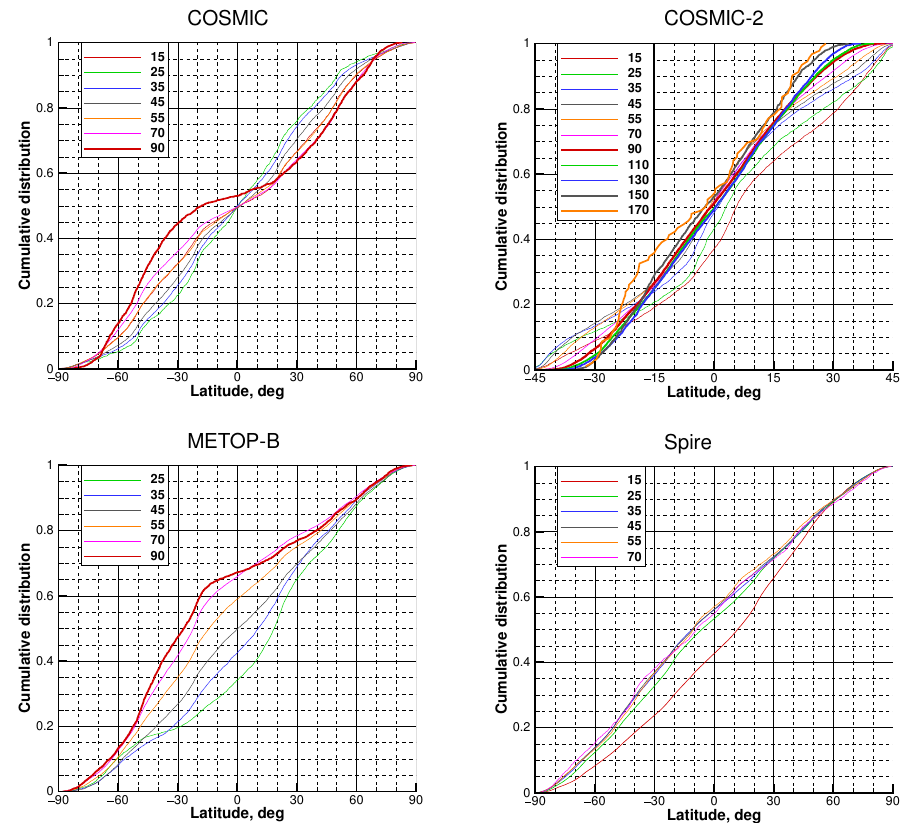
Figure 20. The cumulative distributions for the four